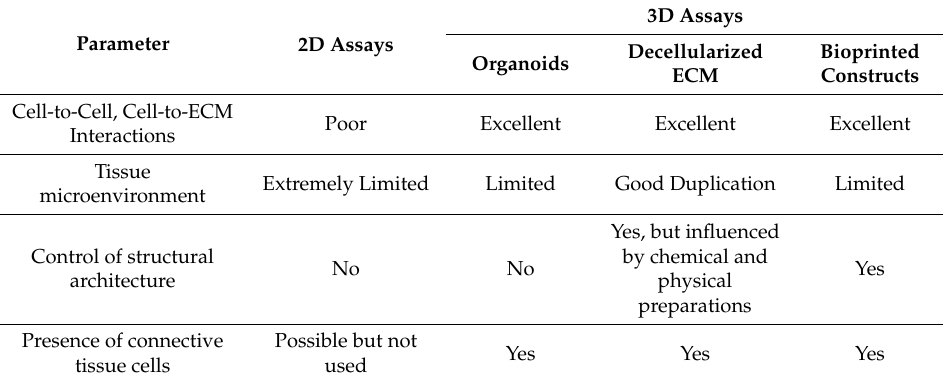
Table 3. Comparison between 2D and 3D cell culture